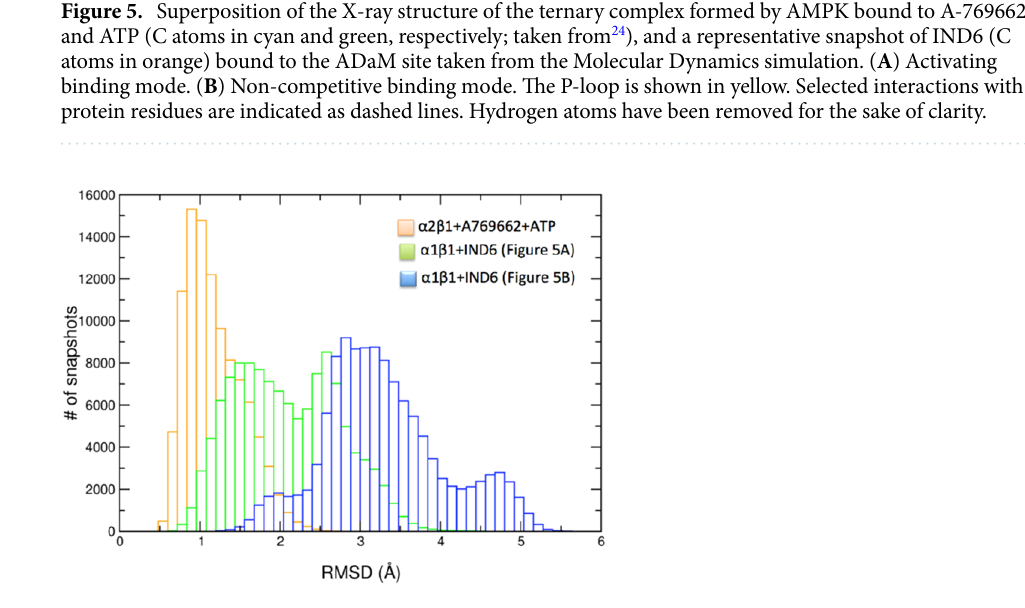
Figure 6. Distribution of the positional deviation (RMSD; Å) of the backbone atoms that shape the ATP- binding along the trajectories run for the two binding modes of IND6 bound to AMPKα1β1 (shown in Fig. 5A,B), and for the ternary complex between A-769662, ATP and AMPKα2β1 (data taken from 24